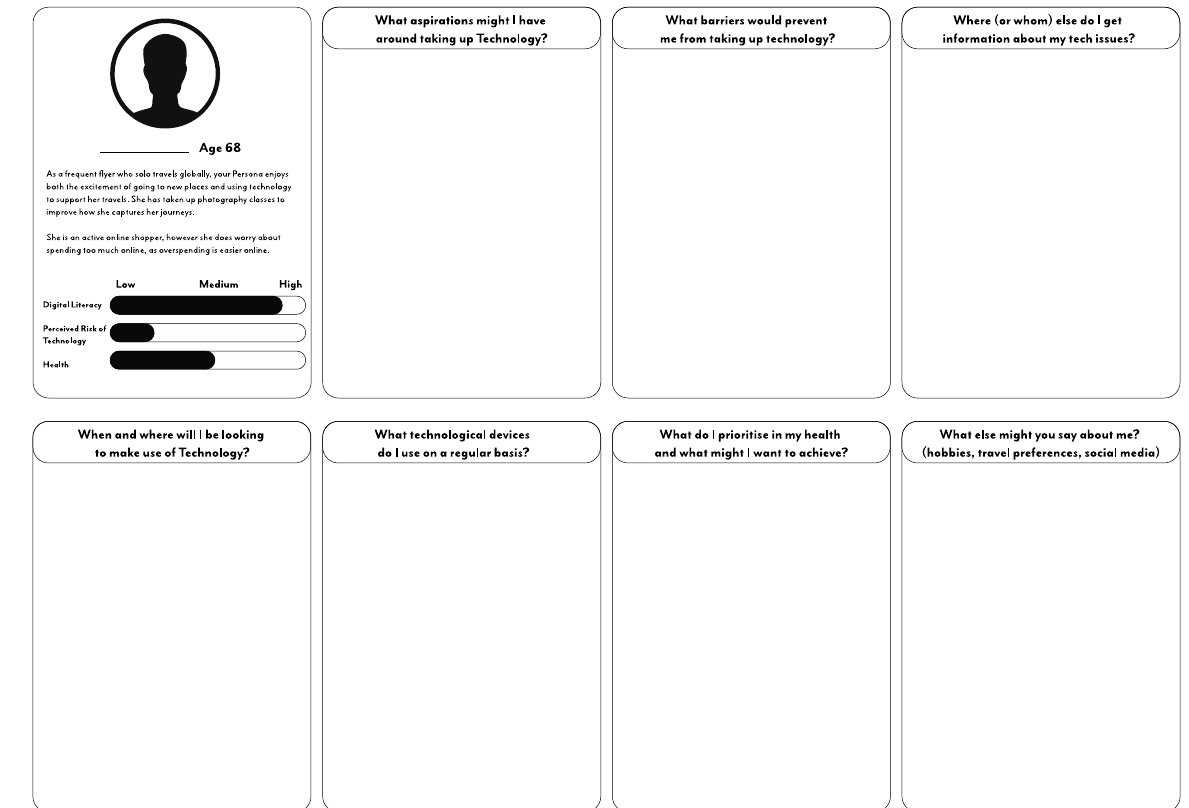
Figure 3. Persona enrichment template.